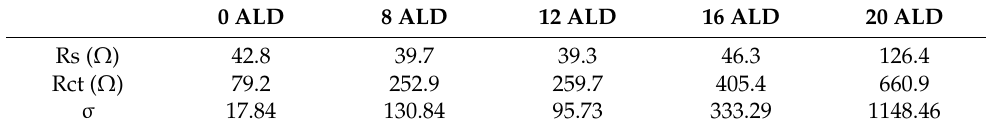
Table 1. Impedance parameters of Cr 8 O 21 all-solid-state cell with different ALD cycles (0, 8, 12, 16, 20). 0